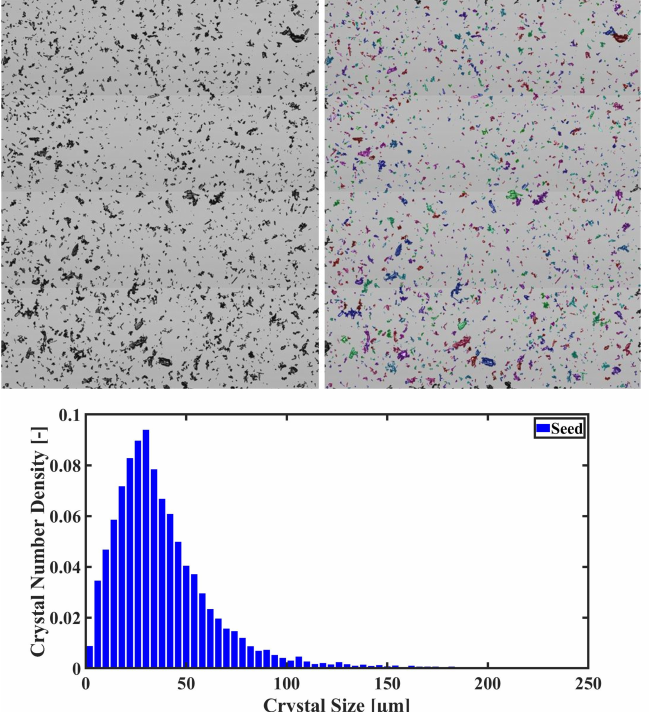
Figure 3. Microscopy pictures of the seed material ( top-left ), detected particles by the image analysis algorithm ( top-right ), and calculated fractional number density distribution ( bottom ) assuming a constant bin width of 4 µ